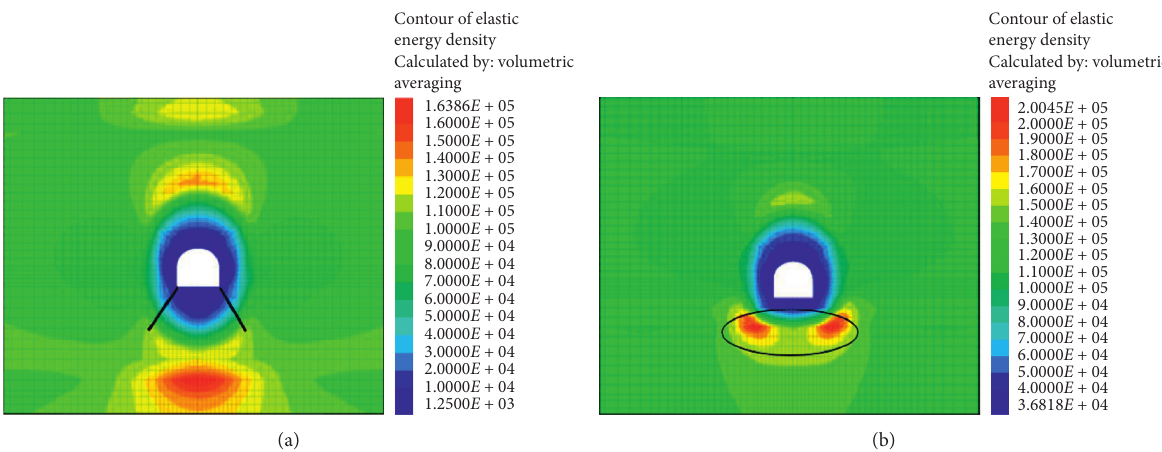
Figure 17: Elastic energy cloud diagram of roadway rock. (a) Floor for pressure relief and support (b) Floor without